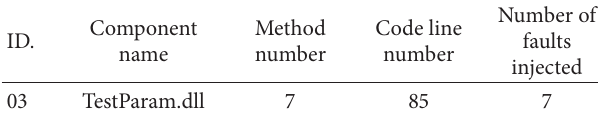
Table 6: The information of